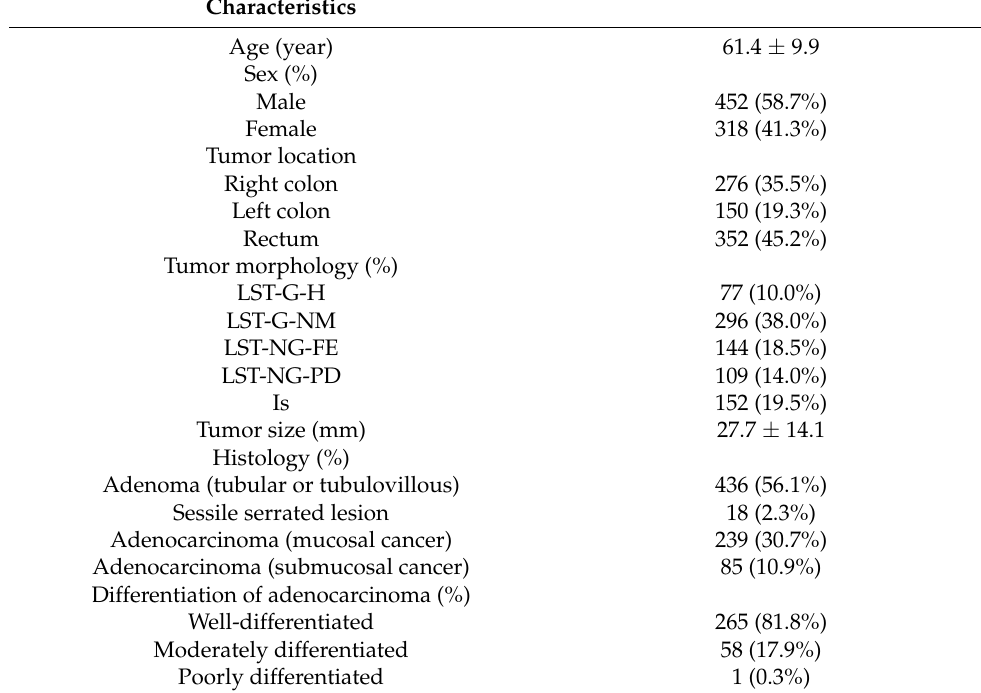
Table 1. Baseline characteristics of the patients and colorectal